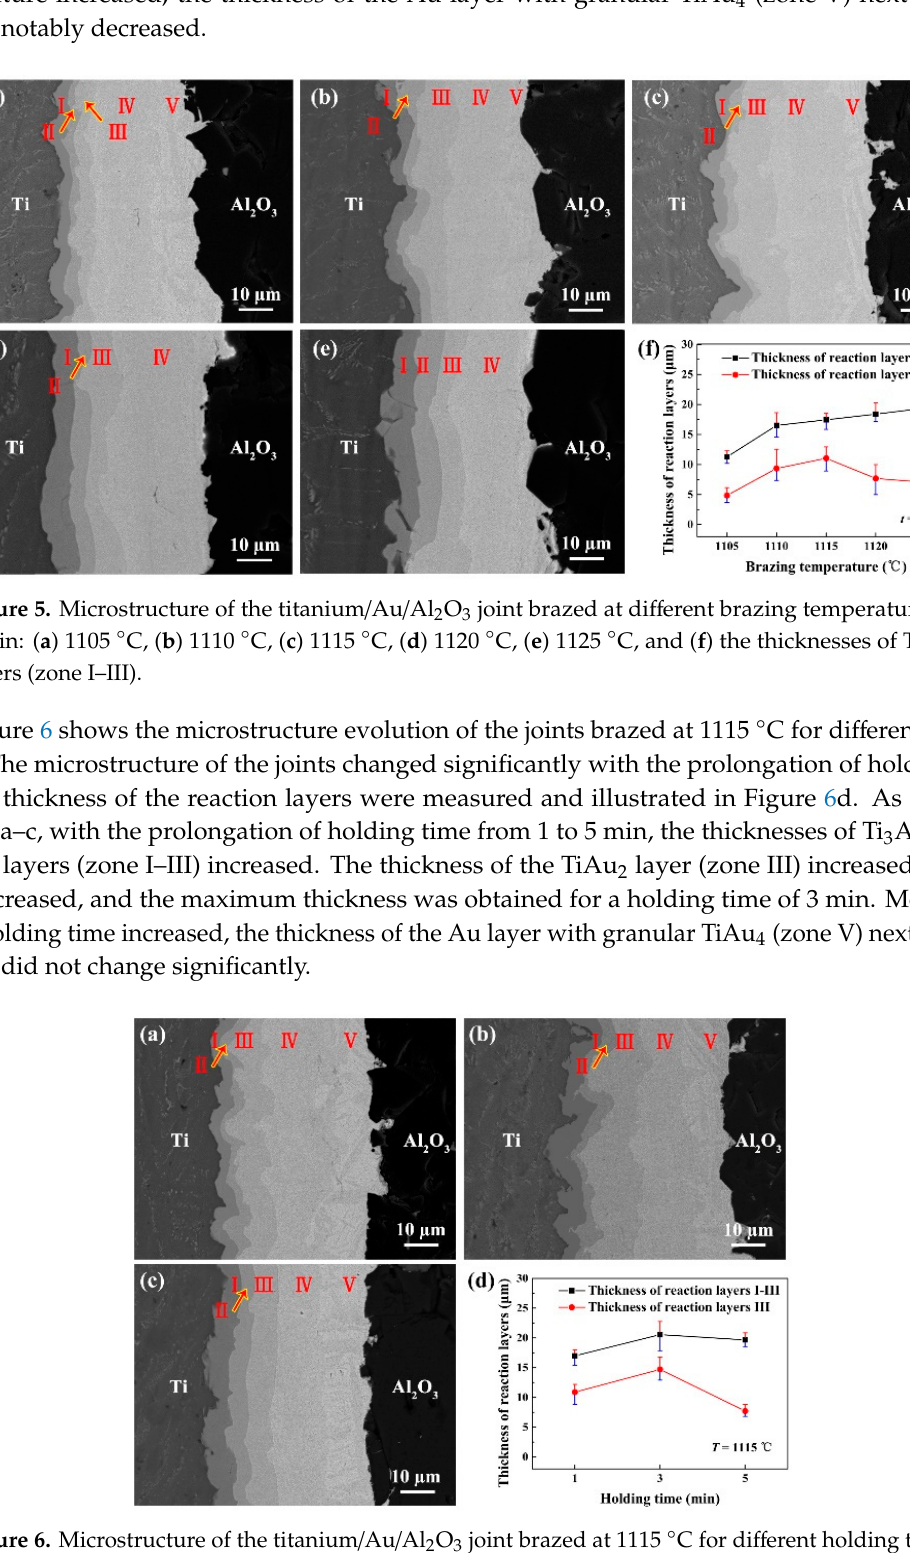
Figure 6. Microstructure of the titanium/Au/Al 2 O 3 joint brazed at 1115 °C for different holding times: ( a ) 1 min, ( b ) 3 min, ( c ) 5 min, and ( d ) the thicknesses of Ti-Au layers (zone I-III).